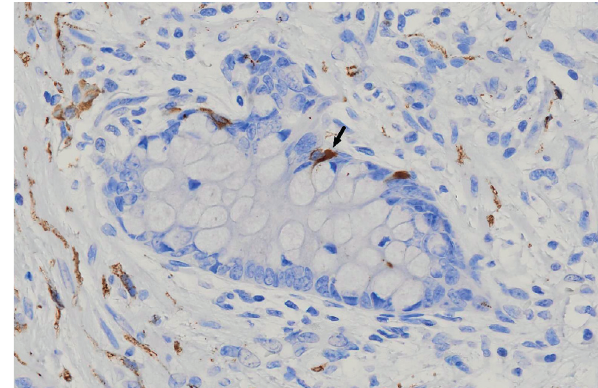
Fig. 5b. Immunohistological reaction with an antibody against synaptophysin. The tumor cells are negative. There are sparse non-tumor positive neuroendocrine cells (arrow) (synaptophy- sin,